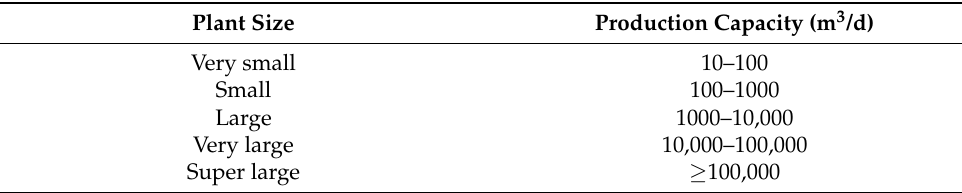
Table 2. Desalination plant size classification.